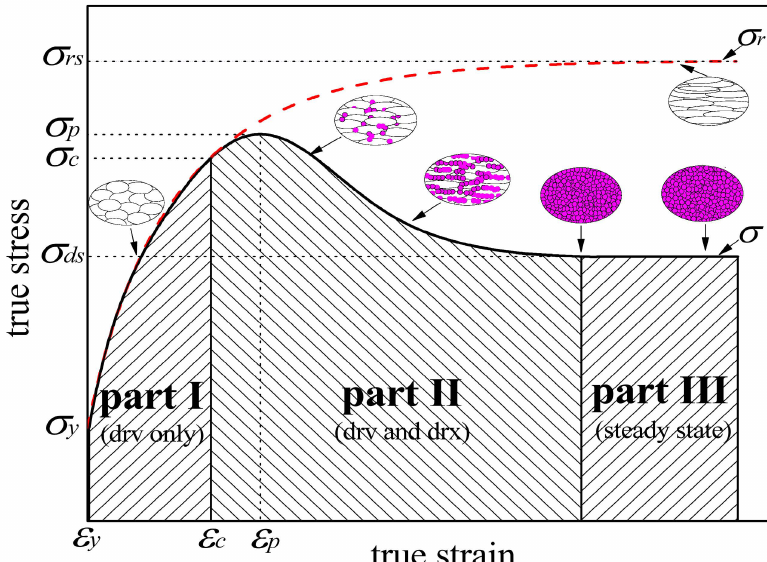
Figure 1. Schematic illustration of the microstructure evolvement and the division of the true stress-strain curve in the hot deformation process. According to the difference of the microstructure evolvement, the true stress-strain curve ( σ ) is divided into three parts (part I, part II and part III). Part I undergoes the dynamic recovery (DRV) process. Part II is the initiation of the dynamic recrystallization (DRX) process while these un-recrystallized regions still undergo the DRV process. Part III is the steady state; all the original microstructure has been recrystallized and reaches a dynamic equilibrium in this part. The dashed curve ( σ r ) represents the work-hardening behavior of part I and the un-recrystallized regions in part II.